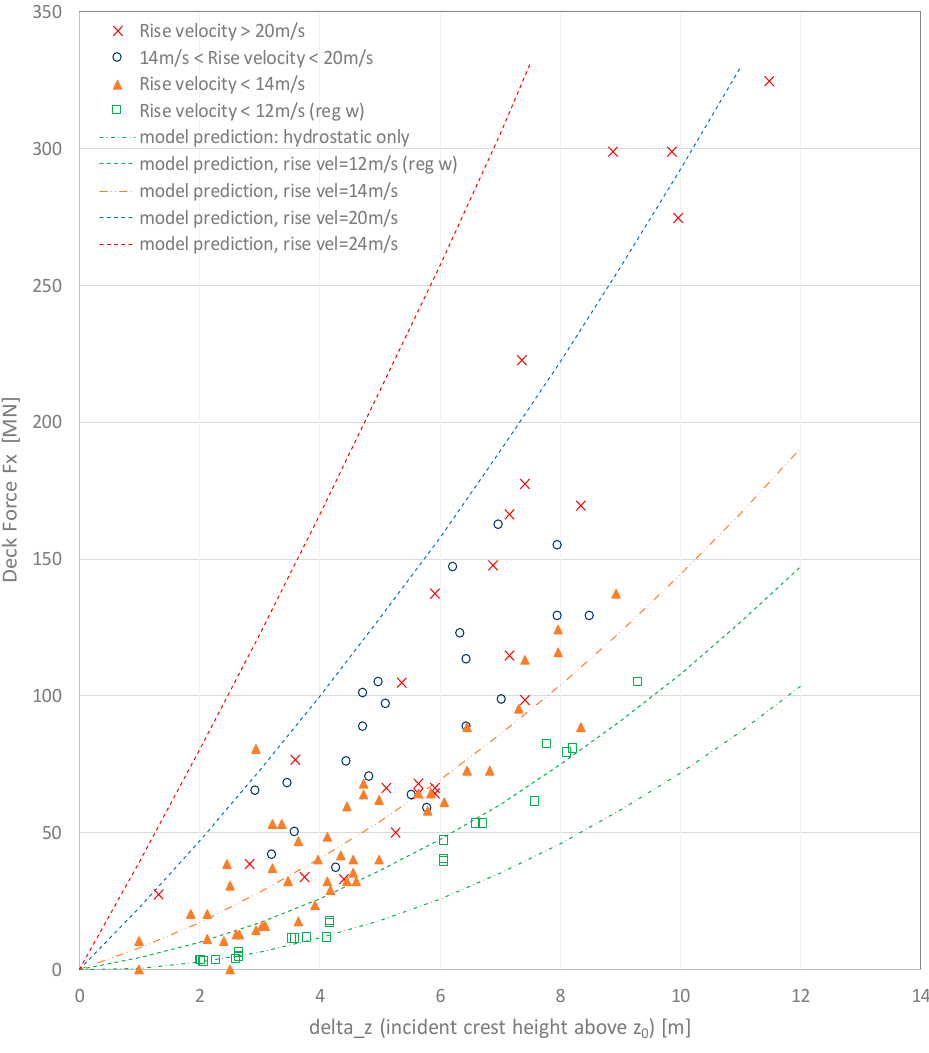
Figure 15. Correlation between measured global impact force peaks and corresponding incident crest height above reference level z 0 . Here, z 0 = 15 m for water depth 151.6 m and 16.5 m for water depth 150.1 m. Estimates from simple theoretical model Equation (9) are also indicated.